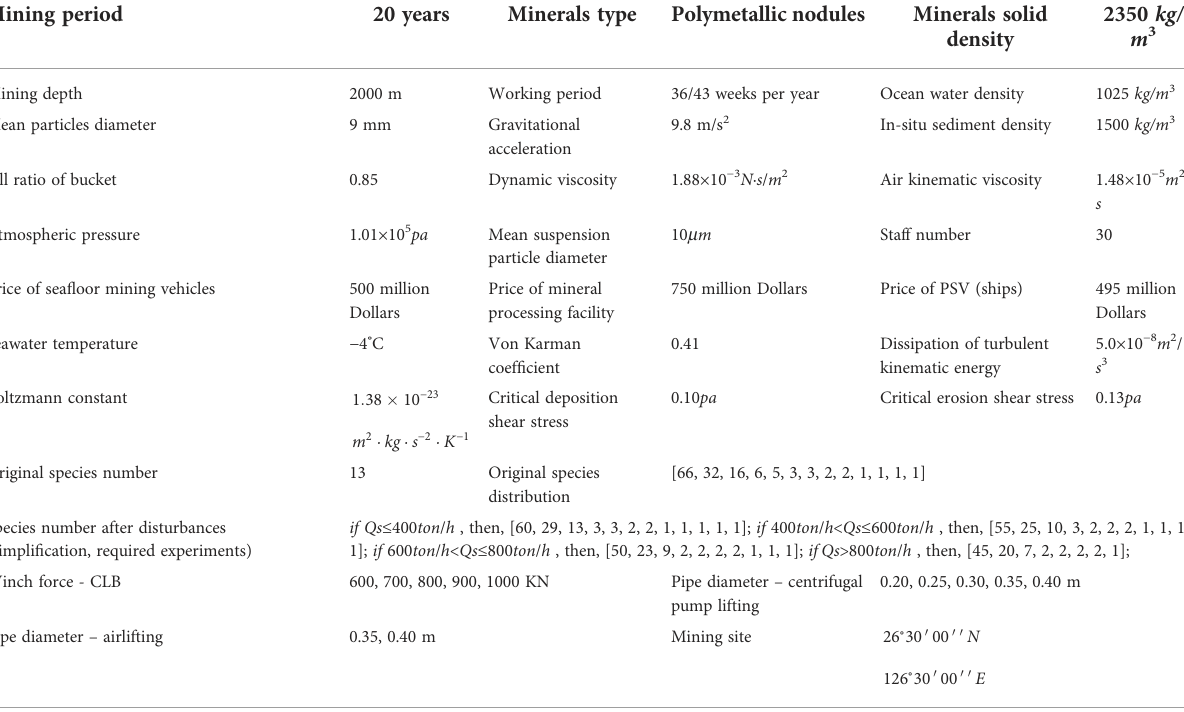
TABLE 3 Given parameters in MCDM application for sustainable DSM vertical transport plan